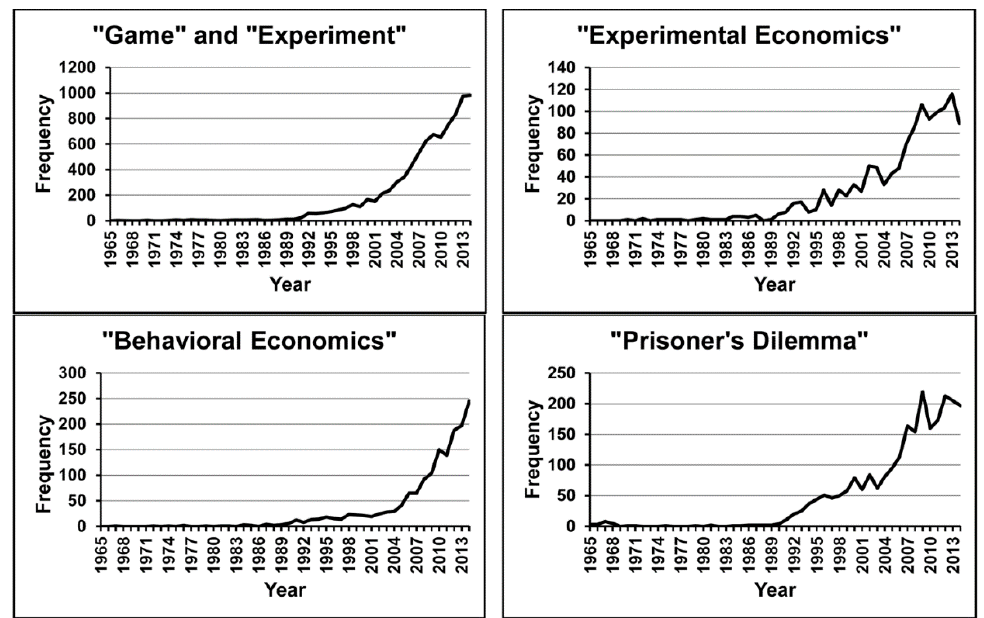
Figure 1. Per annum frequency of keywords game and experiment (co-occurring), experimental economics , behavioral economics , and Prisoner’s Dilemma in the Web of Science databases, 1965 through